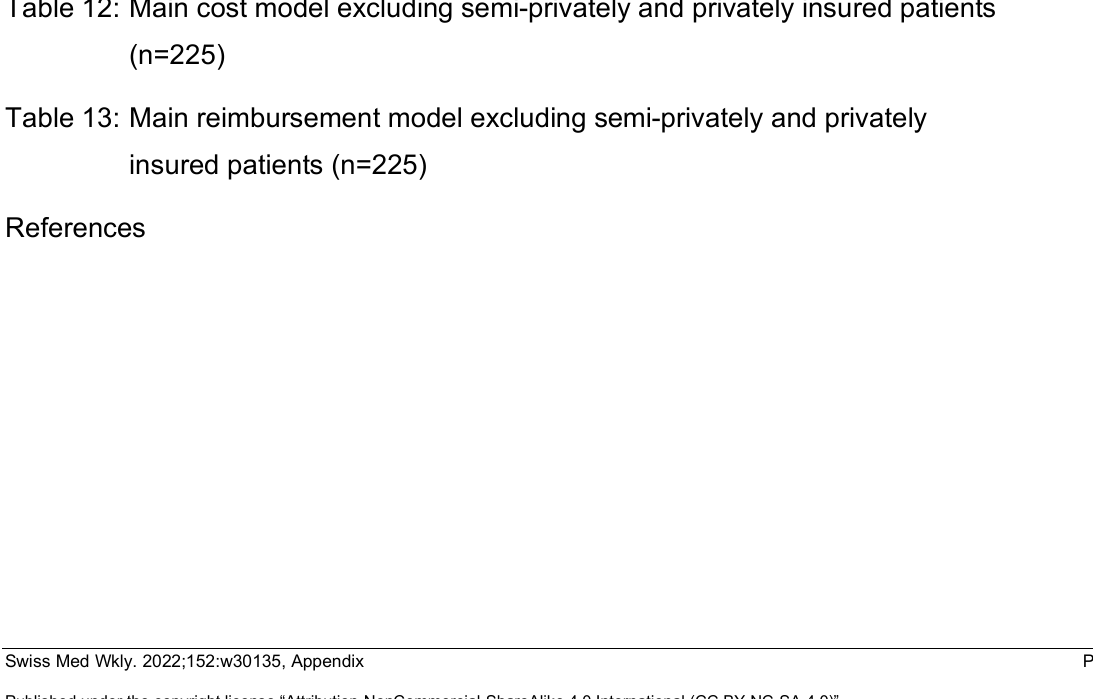
Table 1: ASA physical status relevant comorbidities and corresponding ASA class grading, including remarks Table 2: Complete cost model with full output (n=320) Table 3: Complete reimbursement model with full output (n=320) Table 4: Cost model including all patients (n=320) Table 5: Reimbursement model including all patients (n=320) Table 6: Log-cost model excluding recurrent patients (n=315) Table 7: Log-reimbursement model excluding recurrent patients (n=315) Table 8: Cost model excluding recurrent patients and patients with a protracted hospital or ICU stay (n=310 Table 9: Reimbursement model excluding recurrent patients and patients with a protracted hospital or ICU stay (n=310) Table 10: Cost model excluding recurrent patients (n=315) Table 11: Reimbursement model excluding recurrent patients (n=315) Table 12: Main cost model excluding semi-privately and privately insured patients (n=225) Table 13: Main reimbursement model excluding semi-privately and